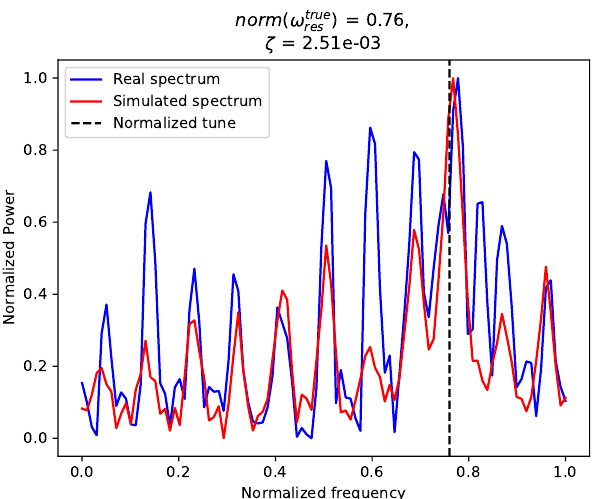
Figure 5. Second order simulation of a real spectrum obtained from the BBQ